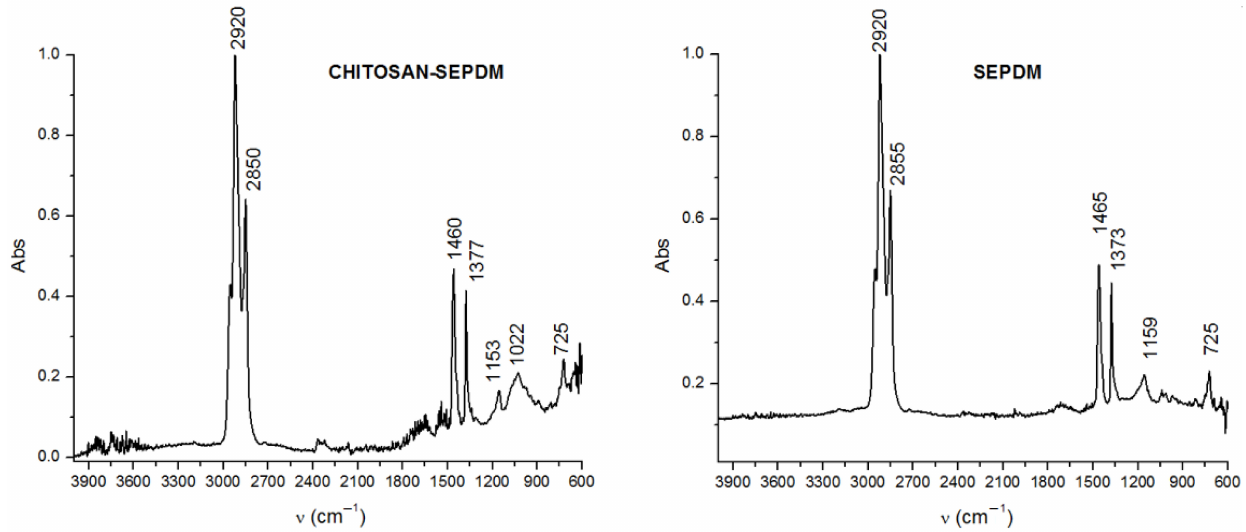
Figure 7. Fourier transform infrared spectra for the composite membranes: sEPDM and Chi/sEPDM composite